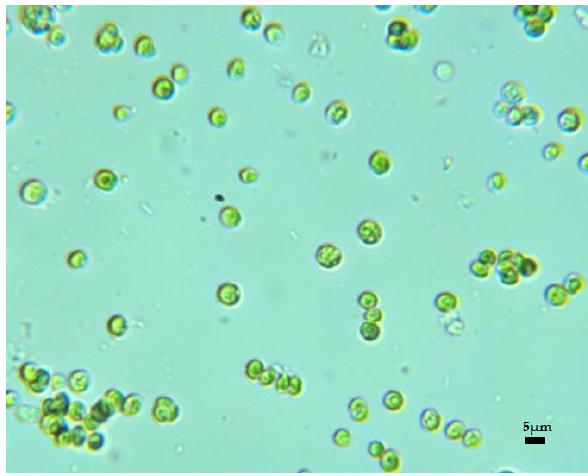
Figure 1. Light microscope image of Chlorella minutissima obtained during the cultivation process.